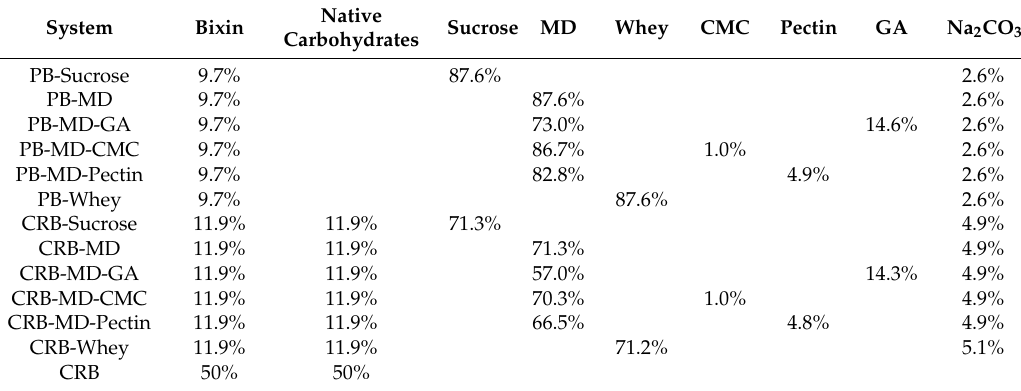
Table 1. Initial compositions of the total solids for each prepared system prior spray drying. System Bixin